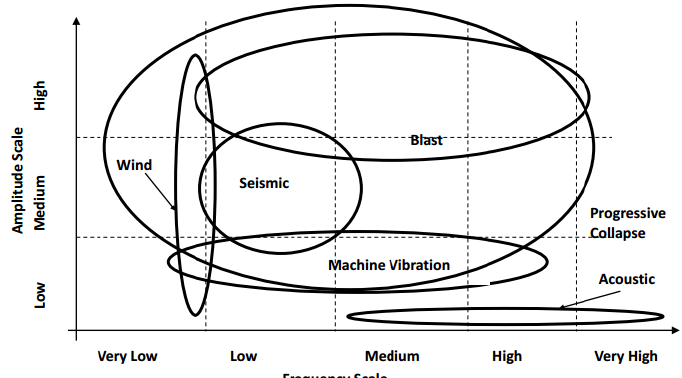
Fig. 5: Distribution for different hazards produced from HE and LE [3].